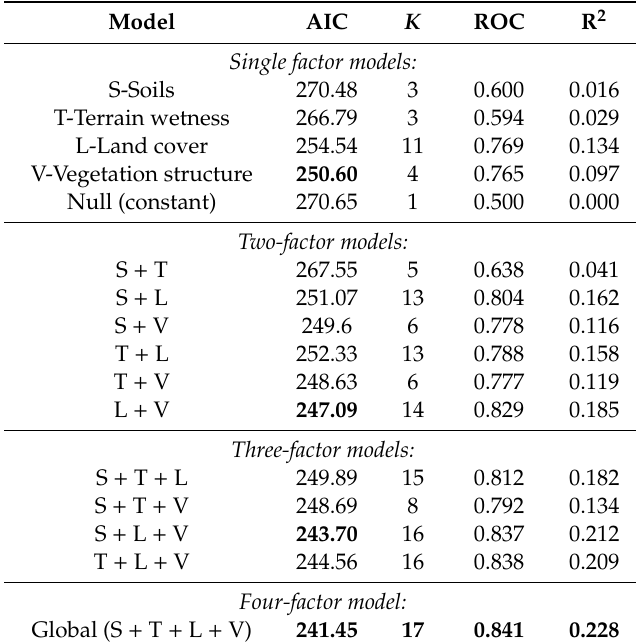
Table 2. Comparison of candidate models describing the presence of rare plants (S1 or S2 rank) within 0.25 ha plots ( n = 469) in the Lower Athabasca region based on soils (S), terrain (T), land cover (L), and vertical vegetation structure (V). AIC values in bold font represent the most-supported model (lower AIC) within single, two, three, and four-factor sets. Model complexity is represented by number of parameters ( K ). ROC represents predictive accuracy based on Receiver Operating Characteristic, while model fit (R 2 ) was measured by percent deviance